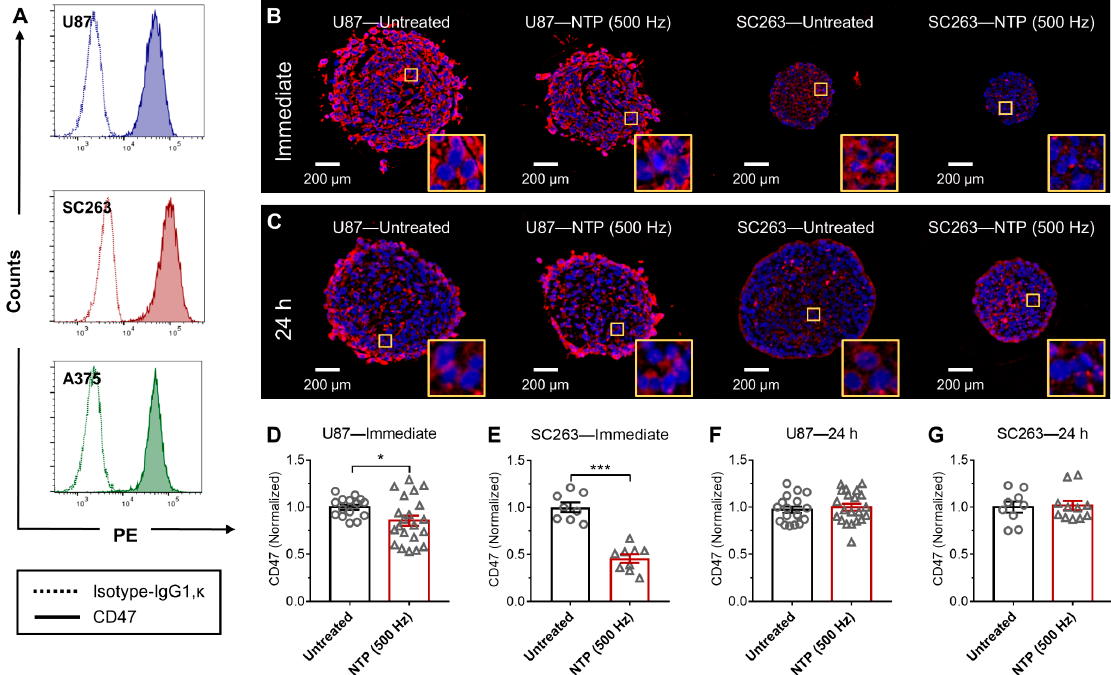
Figure 1. NTP treatment modulated CD47 immediately in 3D tumor spheroids. ( A ) The baseline expression of three human cancer cells, glioblastoma (U87), head and neck squamous cell carcinoma (SC263), and melanoma (A375) was analyzed using immunohistochemistry and flow cytometry. U87 and SC263 cells were able to form compact spheroids and were exposed to NTP. Spheroids were collected ( B ) immediately or ( C ) 24 h after NTP treatment, paraffin-fixed, sectioned, stained for CD47 (red), and counter-stained with a nuclear dye, 4 ′ ,6-diamidino-2-phenylindole (DAPI) (blue). Images were taken together at fixed microscope settings (10×) per experiment and all images were batch processed. Yellow inserts are a zoomed-in area (100 μ m × 100 μ m) to show CD47 staining surrounding the nucleus. CD47 expression was quantified and normalized to the untreated ( D – G ). Data here are represented as mean ± SEM and individual values are also shown (n = 8–21). Statistical significance of all treatment conditions was determined using the generalized linear mixed model with post hoc Dunnett’s test comparison to untreated (* p ≤ 0.05; *** p ≤ 0.001).